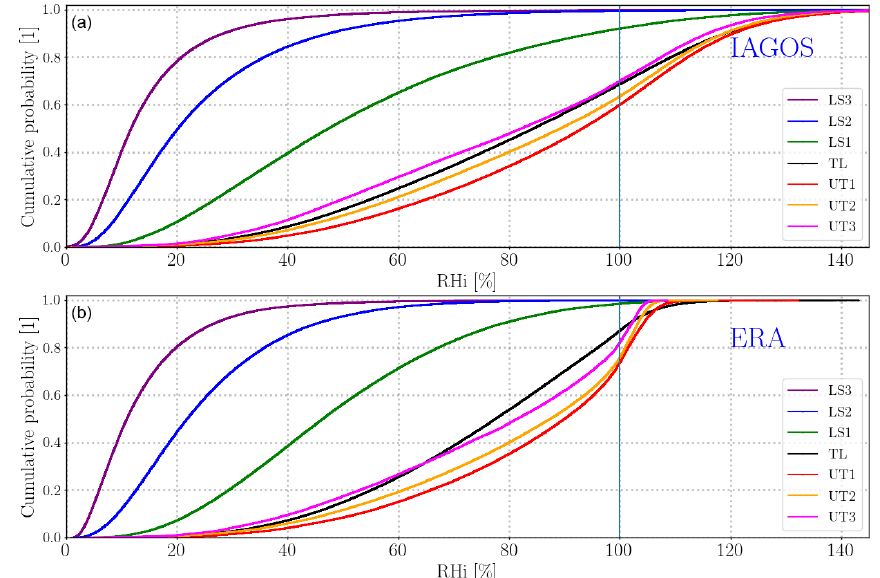
Figure 5. Cumulative distribution of RH i for every height level in the IAGOS (a) and ERA (b) data sets. The vertical blue line denotes saturation with respect to ice.